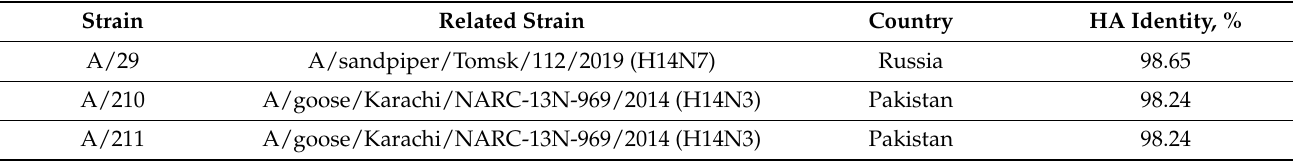
Table 5. Nucleotide identity of the HA segment of Siberian H14Nx viruses. Related Strain Country HA Identity,